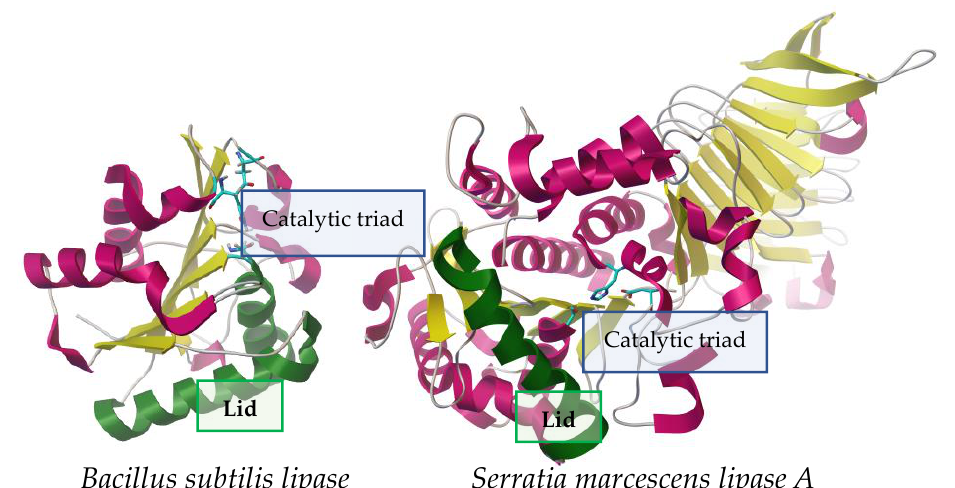
Figure 1. Contrast between two lipases of different sizes from Bacillus subtilis (19 kDa, left) [58] and Serratia marcescens (64.9 kDa, right) [59], showing structural similarities such as: lid (represented in green), active center (represented by sticks), α -helices (pink) and β -lamina (yellow). PDB structures 5cri (Bacillus subtilis) and 2aqua (Serratia marcescens), visualized with AutoDockTools 4.2.